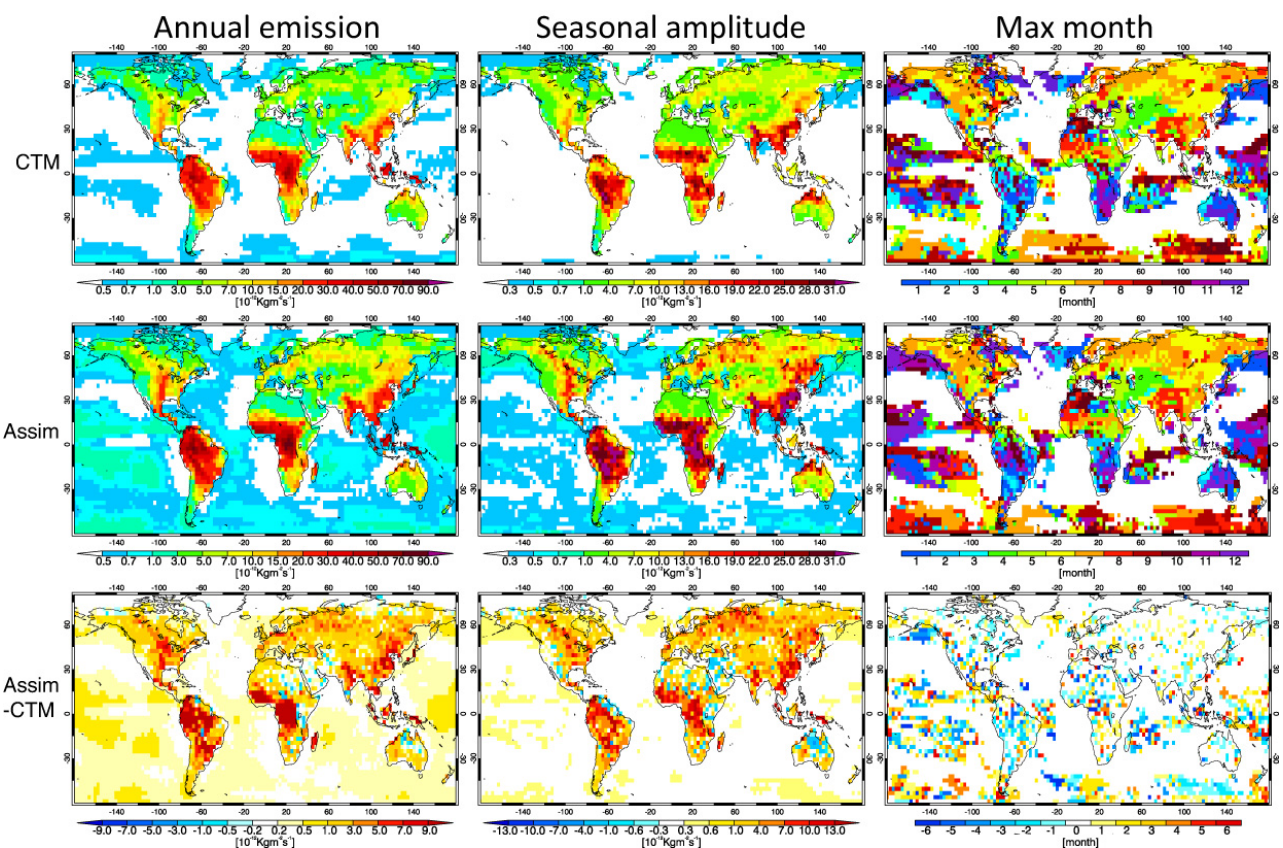
Fig. 6. Global distributions of the annual LNO x source (left panels, 10 − 12 kgm − 2 s − 1 ), its seasonal amplitude (center panels, in 10 − 12 kgm − 2 s − 1 ), and the timing of peak sources (right panels, in months) for 2007. Shown are the a priori sources estimated from the CTM parameterization (upper panels), the a posteriori sources from the data assimilation (middle panels), and the analysis increment (lower panels). The analysis increment equals the a posteriori sources minus the a priori sources. The peak timing is estimated for regions with the analyzed annual sources of LNO x greater than 0 . 7 × 10 − 13 kgm − 2 s − 1